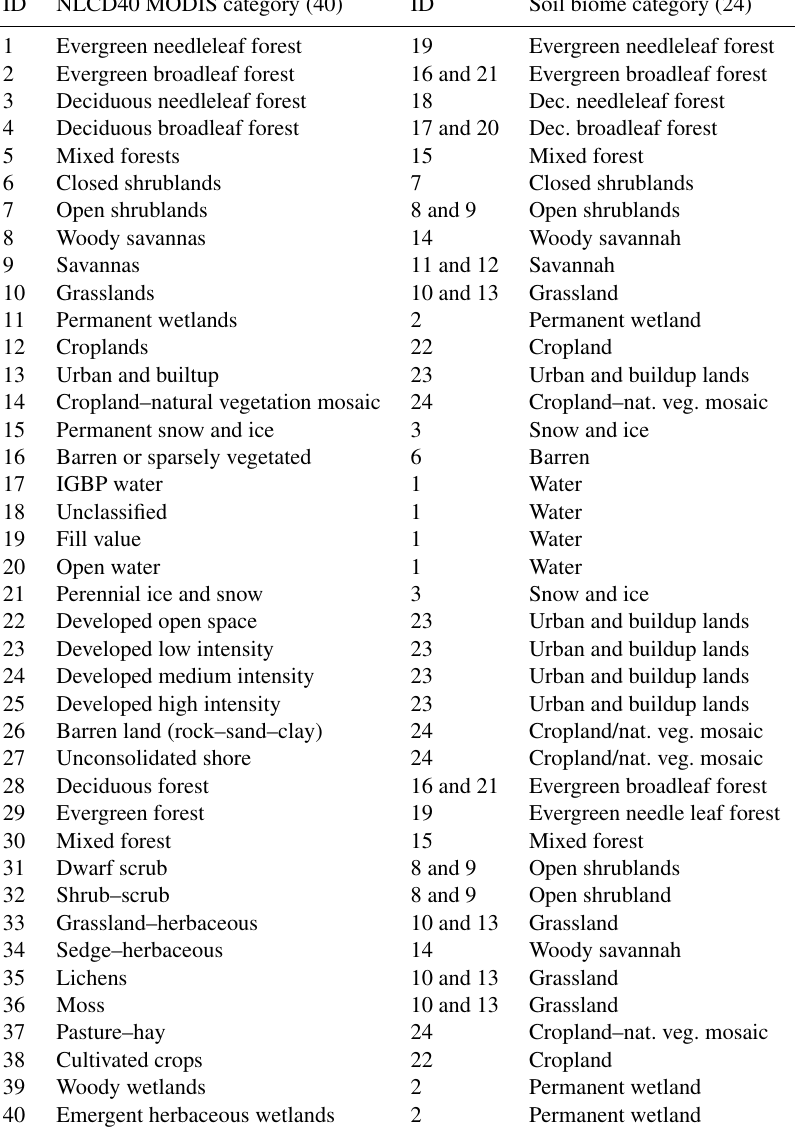
Table A2. Mapping table to create the “new” soil biome map based on NLCD40 MODIS land cover